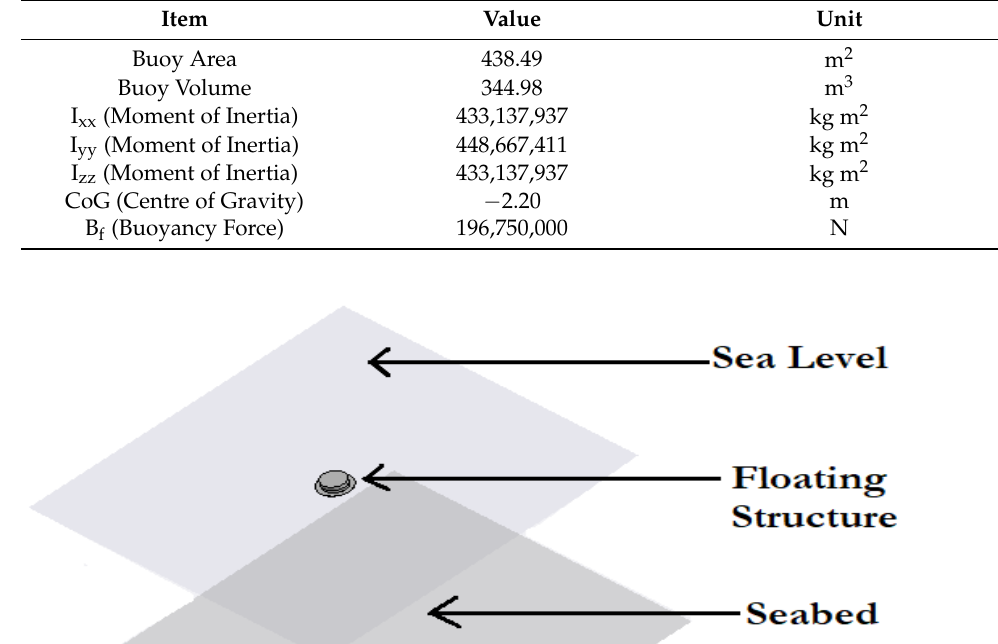
Table 10. Parameters for the buoy hydrostatics.